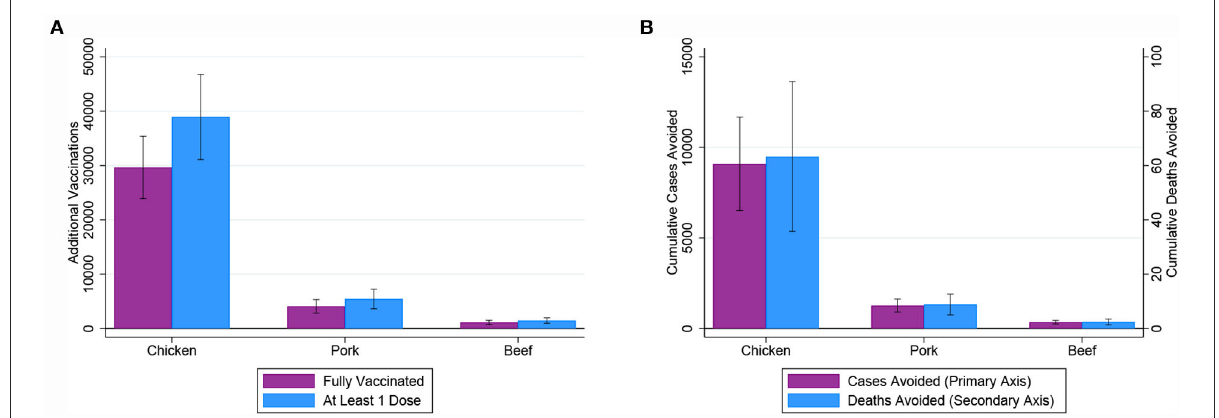
FIGURE4 Impacts on national vaccine uptake and COVID-19 incidence. Figure shows the total number of vaccinations induced by the Tyson employee vaccine mandate and the corresponding number of COVID-19 cases and deaths avoided, broken down by Tyson plant type. Count values for chicken plants exceed those of pork or beef plants because Tyson operates many more chicken facilities than the other meat types. (A) Vaccinations by plant type. (B) COVID-19 incidence by plant